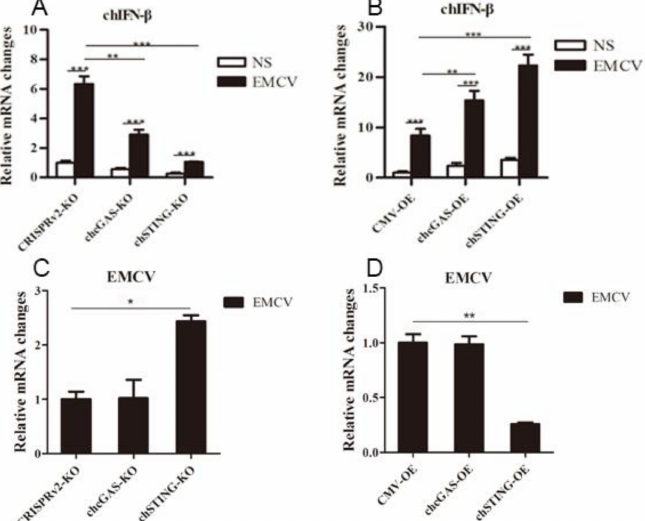
Figure 9. EMCV replications in chGAS and chSTING stable HD11 cells. HD11 KO and OE stable cells in 12-well plate (2 × 10 5 cells / well) were infected with EMCV (0.01 MOI) for 14 h and 14 h, respectively. The cells were analyzed by RT-qPCR for both cellular gene transcriptions ( A,B ) and viral gene transcriptions ( C,D ). The signs “*”, “**”, “***” denote p < 0.05, p < 0.01 and p < 0.001,